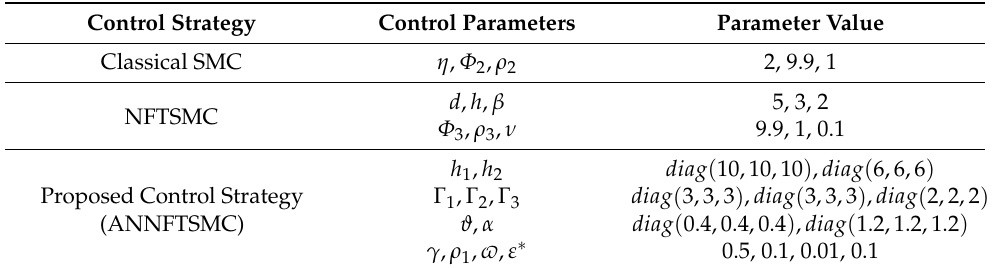
Table 1. The control parameter selection for the varying control strategies. SMC = sliding mode